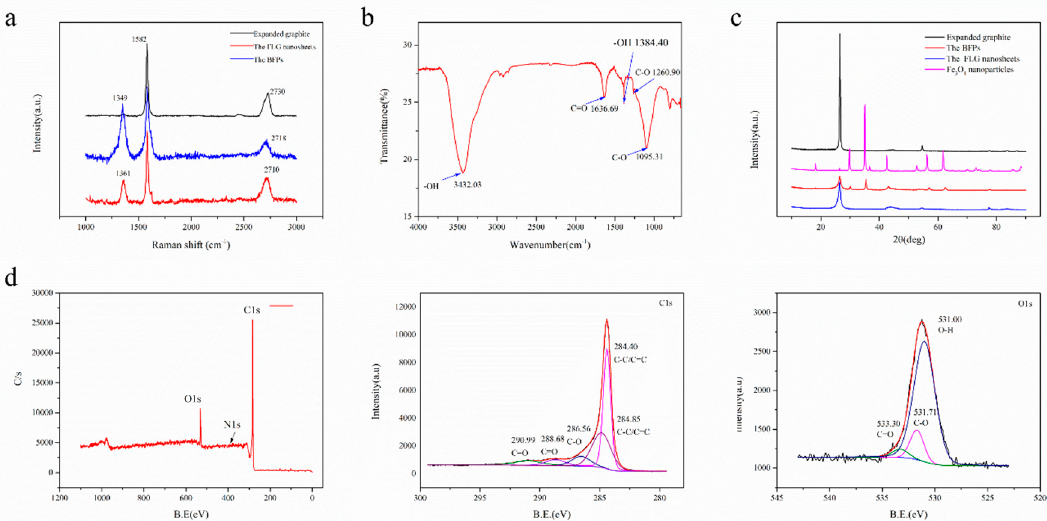
Figure 5. ( a ) Raman characterization of the expanded graphite, the products were only obtained by